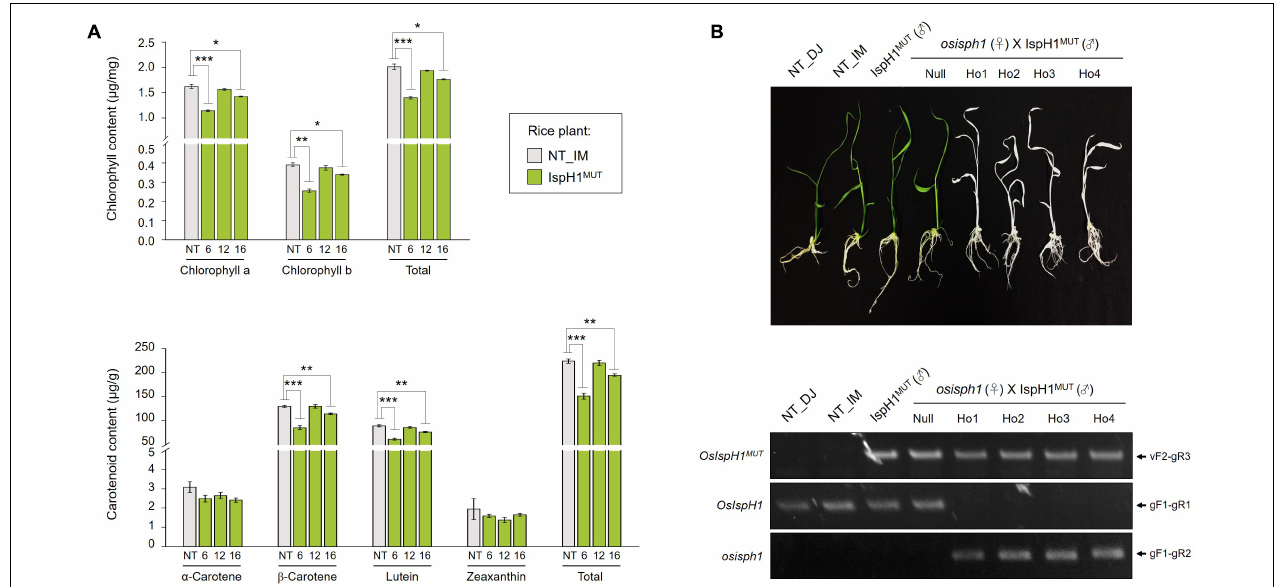
FIGURE 6 | Effects of the OsIspH1 MUT on rice leaves. (A) Contents and composition of chlorophylls and carotenoids in the leaves at T4 plants. Non-transgenic (NT) rice plants ( O. sativa L. cv. Ilmi) and three independent IspH1 MUT transgenic plants were used for metabolite analysis. All data are represented as the mean ± SE of three independent measurements. Statistical analyses were performed using a one-tailed Student’s t -test, and significant differences were indicated by a p -value (* p < 0.05, ** p < 0.01, and *** p < 0.001). (B) Functional complementation in osisph1 rice plants. Phenotypes of 10-day-old seedlings by interbreeding between heterozygous osisph1 and IspH1 MUT transgenic plants at F4 generation and genomic PCR to confirm genotypes using primer sets listed in Supplementary Table 10 .